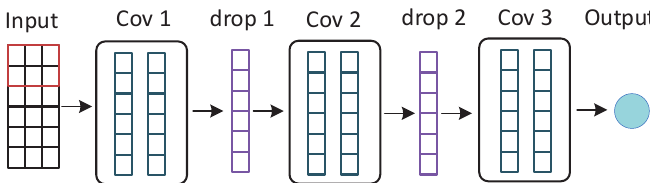
Figure 4. Convolutional Neural Network (CNN) model structure with three convolutional